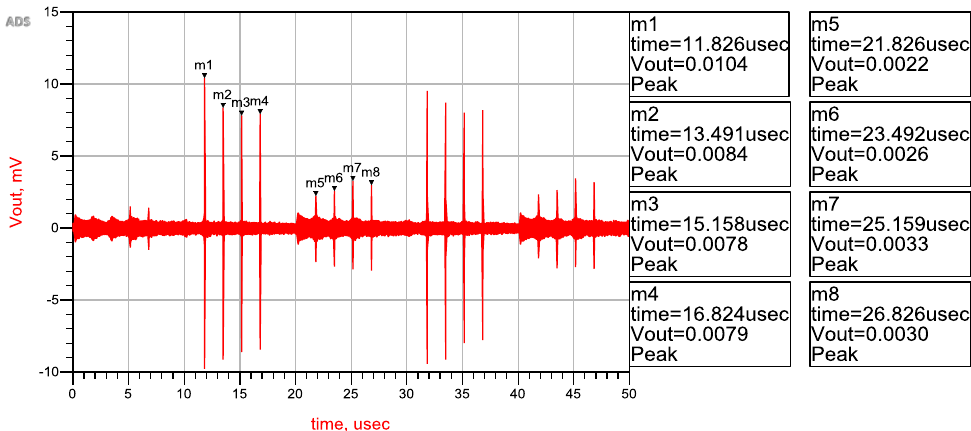
Figure 11. Output pulses from experiment results of the novel single-channel CTS structure.